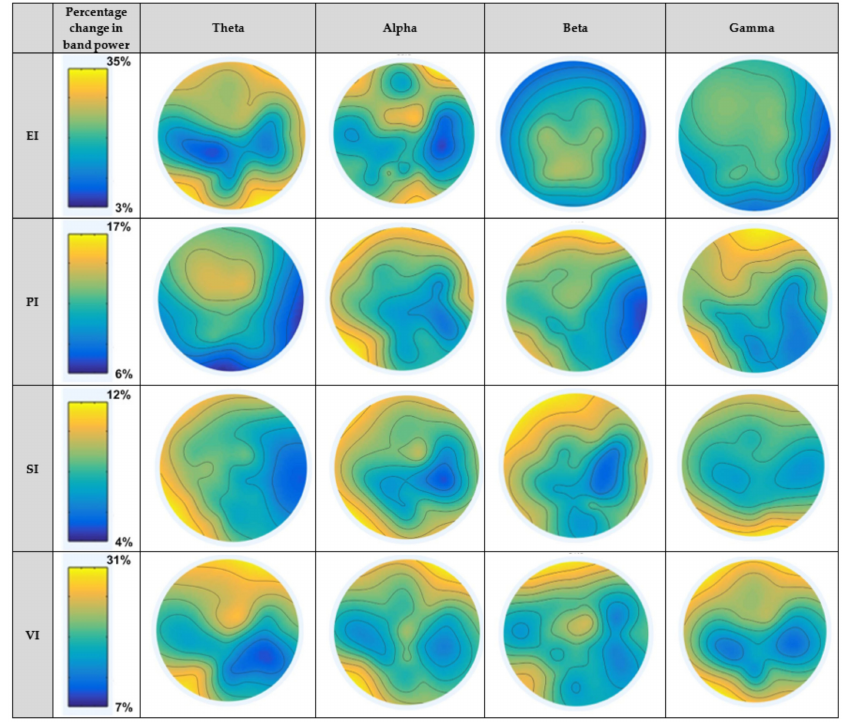
Figure 6. Topographical maps for fear vs. joy emotional states in each of the four considered paradigms for different spectral